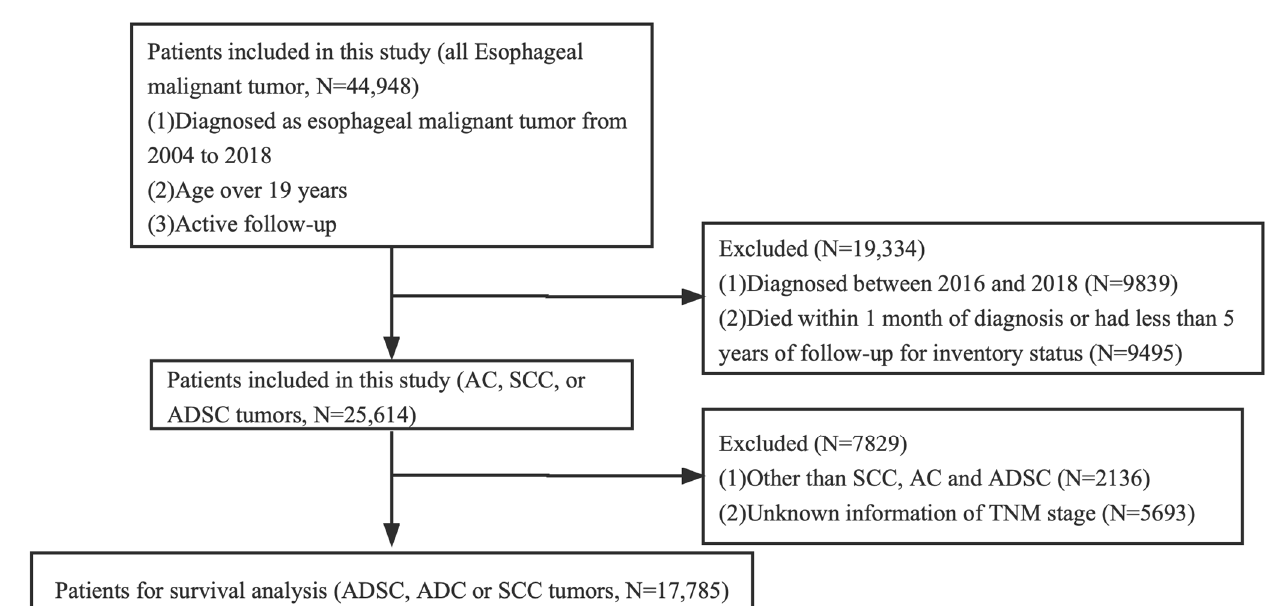
Figure 1. The flowchart of this study.